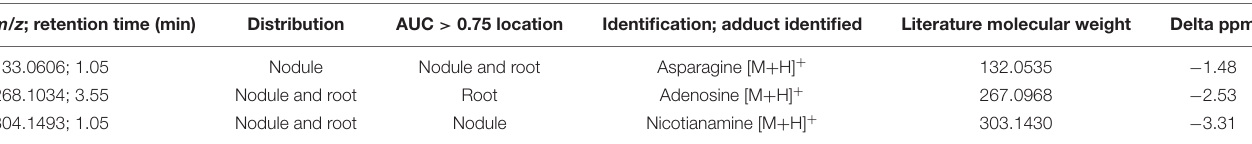
TABLE 1 | Identifications from control roots and root nodules with AUC > 0.75.